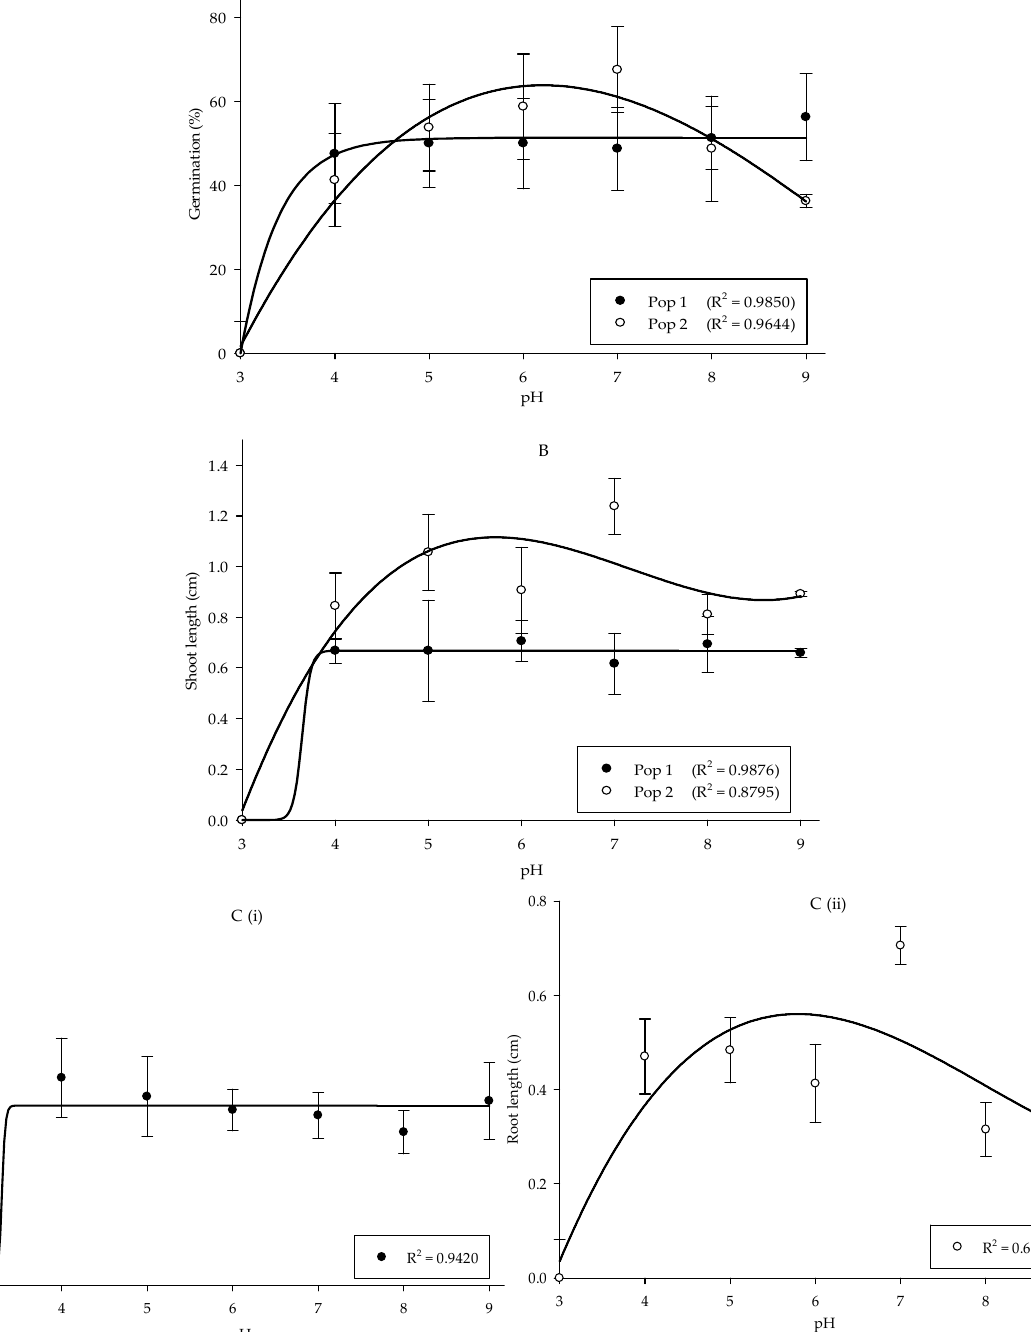
Figure 3. Percentage of seed germination of Pop 1 and Pop 2 ( A ), shoot length of Pop 1 and Pop 2 ( B ), and root length of Pop 1 ( Ci ) and Pop 2 ( Cii ) of Parthenium weed under different pH treatments.